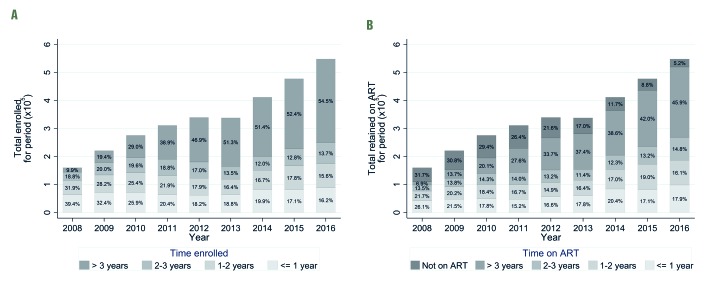
Panel A. Cross-sectional analysis of length of time enrolled in care (percentage and absolute number of patients) by year. Panel B. Cross-sectional analysis of the length of time on antiretroviral therapy (ART) (percentage and absolute number of patients) by year.